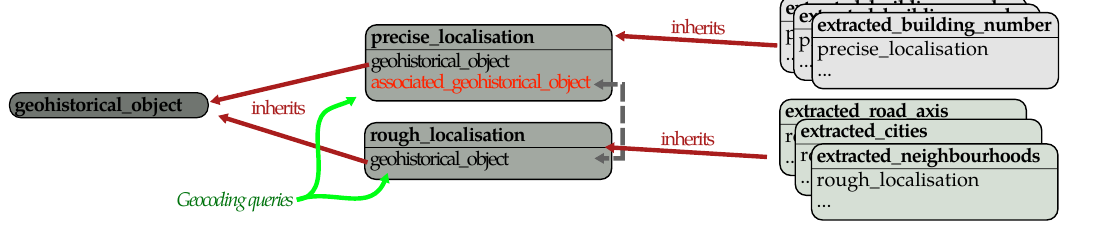
Figure 6. Geocoding table architecture. Two tables of geohistorical_object are the support for geocoding queries. Because all extracted geohistorical object tables inherit from these two tables, they both virtually contain all the